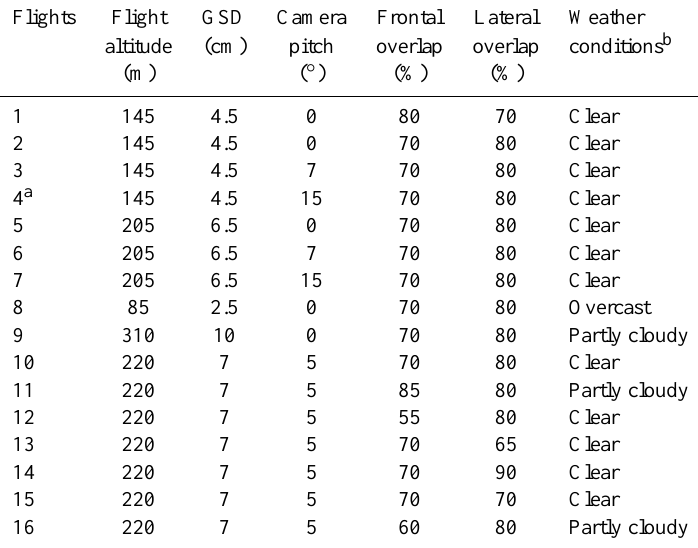
Table 2. Characteristics of the 16 flights. Flights Flight GSD Camera Frontal Lateral Weather altitude (cm) pitch overlap overlap